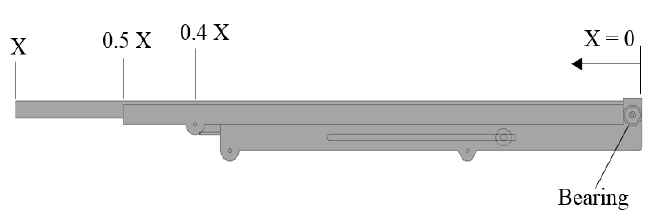
Figure 6. The side view proposed solar photovoltaic tilting platform at an angle θ = 0 o Fig. 6 indicates the side view of the PVTP at θ=0 o ; while X indicates the length of the PV module. The